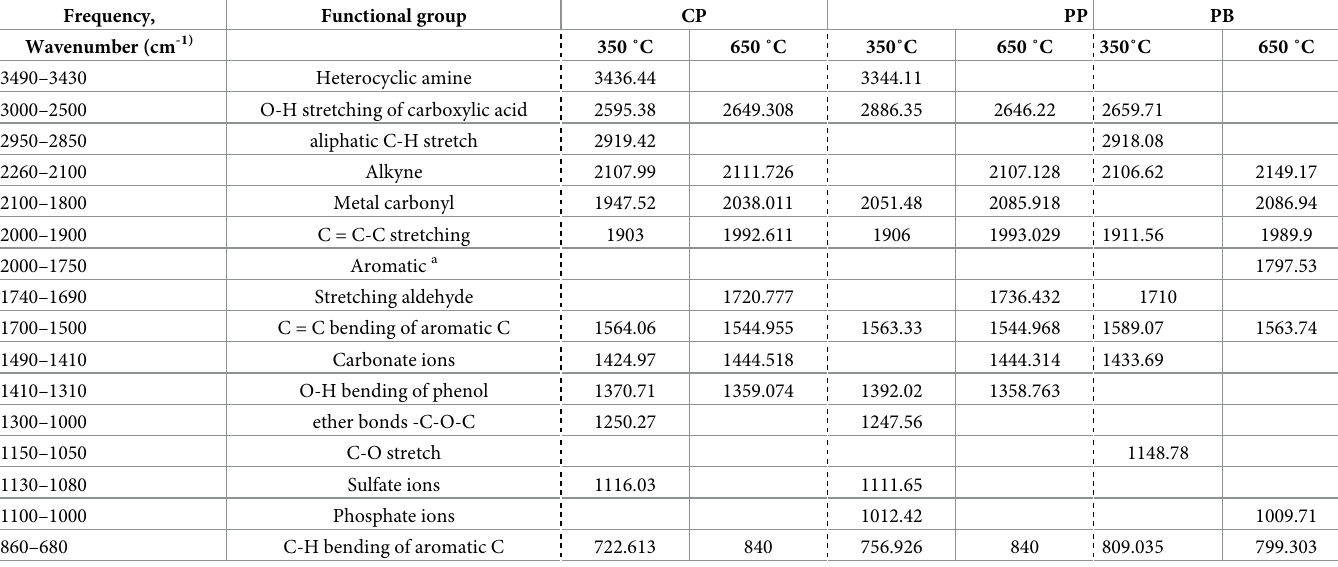
Table 6. FTIR Spectra visible for biochars from potato waste and pine bark